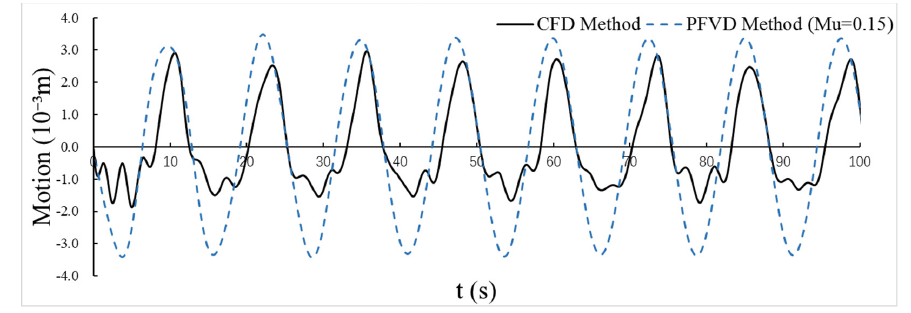
Figure 13. The motion response of the MJWEC with different dissipation coefficients.